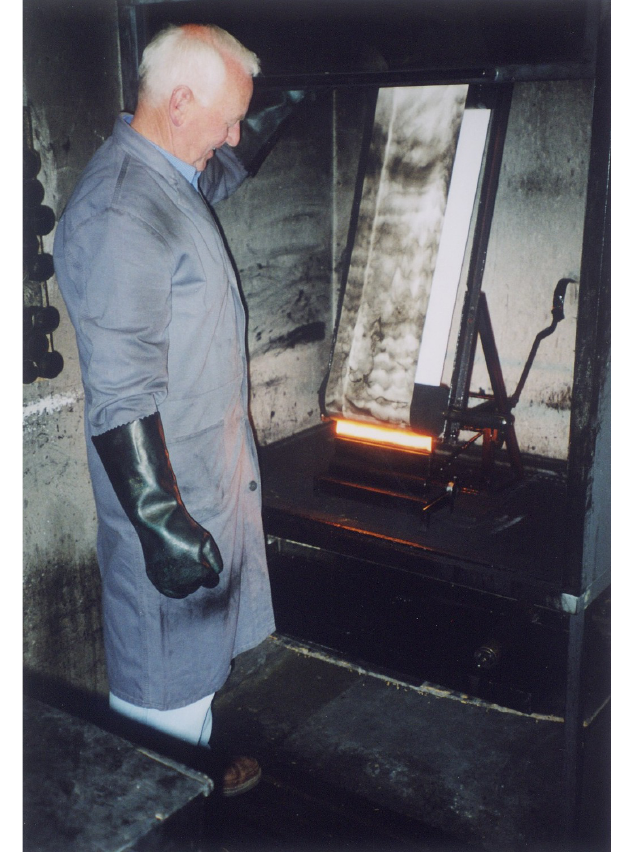
Figure 5. Smoking the paper. Photo: Holger Ste ff en.